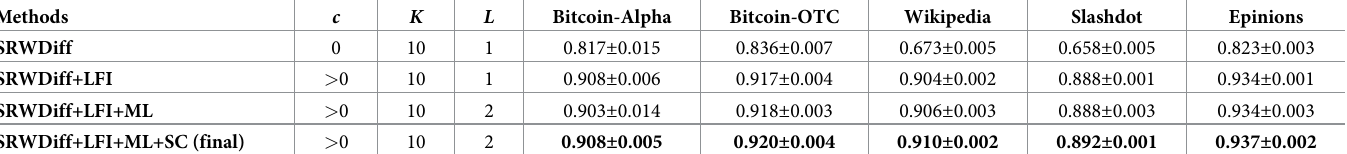
Table 5. Ablation study results on S ID N ET in terms of AUC. The accuracy considerably improves by combining the signed random walk diffusion (SRWDiff) and the local feature injection (LFI). Using multiple layers (ML) together with the skip connection (SC) leads to the best performance of S ID N ET across all tested